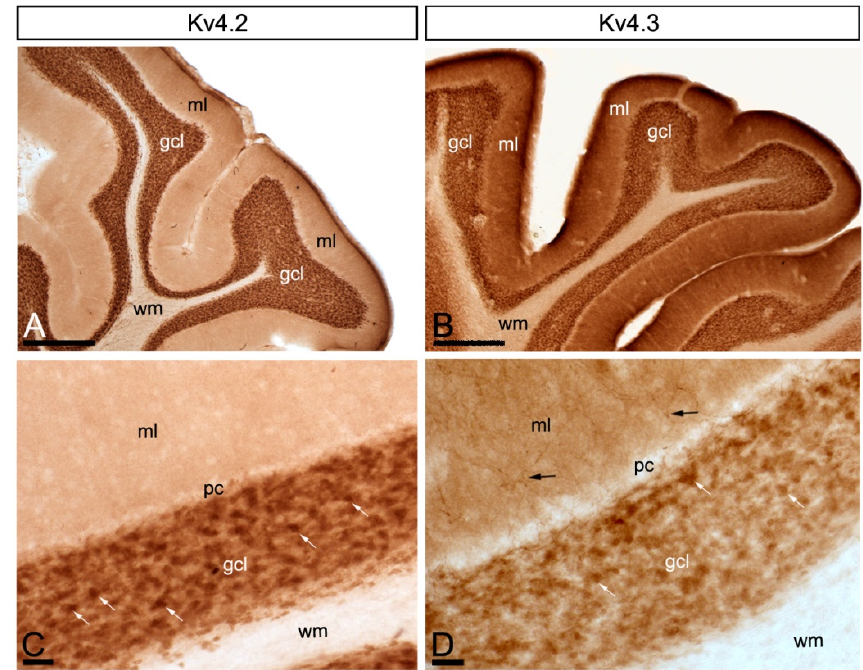
Figure 2. Regional and cellular distribution of voltage-gated potassium (Kv) channel subunits Kv4.2 and Kv4.3 in the cerebellum. ( A – D ) Immunoreactivity for Kv4.2 and Kv4.3 in the rat cerebellar cortex using a pre-embedding immunoperoxidase method at the light microscopic level. Parasagittal photomicrographs of the cerebellar cortex. The strongest immunoreactivity for Kv4.2 and Kv4.3 was found in the granule cell layer (gcl). Strong immunoreactivity for Kv4.3 was also observed in the molecular layer (ml), but weaker for Kv4.2. The white matter (wm) was always devoid of any immunolabelling. Immunoreactivity for Kv4.2 and Kv4.3 in the molecular layer was mostly neuropilar, but Kv4.3 labelling was also detected in cell bodies and dendrites of basket cells (black arrows). In the granule cell layer, Kv4.2 and Kv4.3 immunolabelling particularly concentrated in glomeruli (white arrows) and surrounding GCs. Scale bars: ( A , B ), 50 µ m; ( C , D ), 25 µ m.